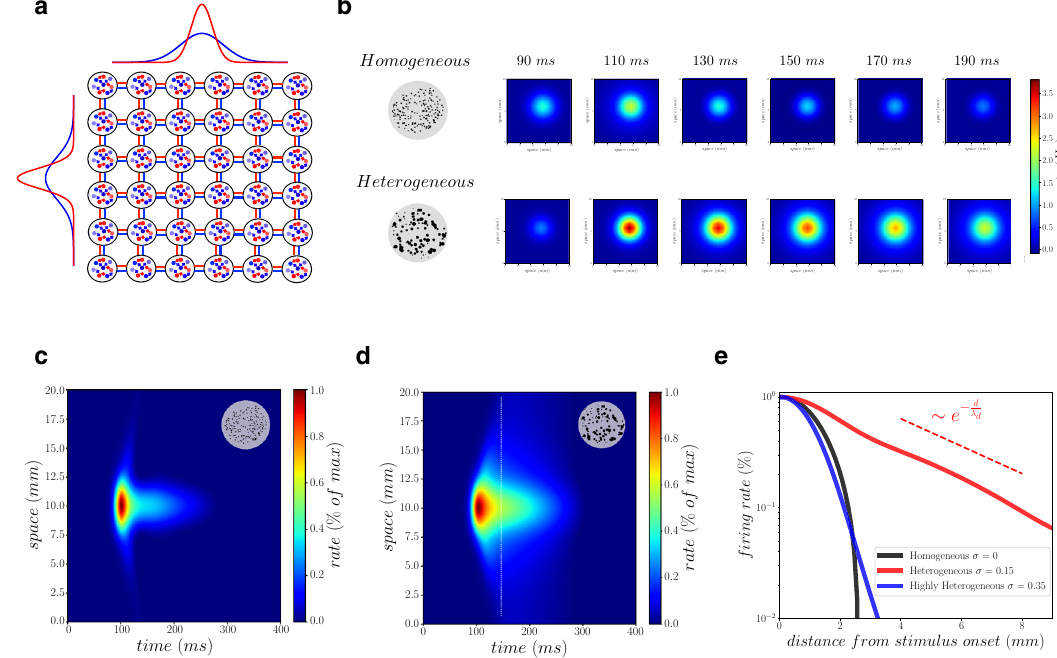
Figure 5. Enhanced activity propagation in large-scale heterogeneous networks. ( a ) Two dimensional lattice of connected mean-field models. The connectivity between excitatory (inhibitory) cells is drawn from a Gaussian distribution with standard deviation of length l exc = 2 mm ( l inh = 1 mm), see blue (red) curves. ( b ) Response of the system (firing rate of excitatory neurons) following a Gaussian afferent stimulus (see “Methods”). The upper row stands for locally homogeneous networks ( σ I = 0 ) while lower row for locally heterogeneous networks ( σ I = 0.15 ). ( c ) Spatio–temporal profile of excitatory neurons firing rate normalised by its maximum in space and time ( σ I = 0 ). ( d ) Same as ( c ) but for σ I = 0.15 . ( e ) Normalised firing rate in function of the distance d from stimulus onset at a specific time [see dashed white line in panel ( d )]. Different colors stand for different levels of heterogeneity (see the legend inside the panel). The dashed red line shows a fit of the exponential decay of activity found in the heterogeneous system (red line, σ I = 0.15 ), with (cid:31) d ∼ 3.5